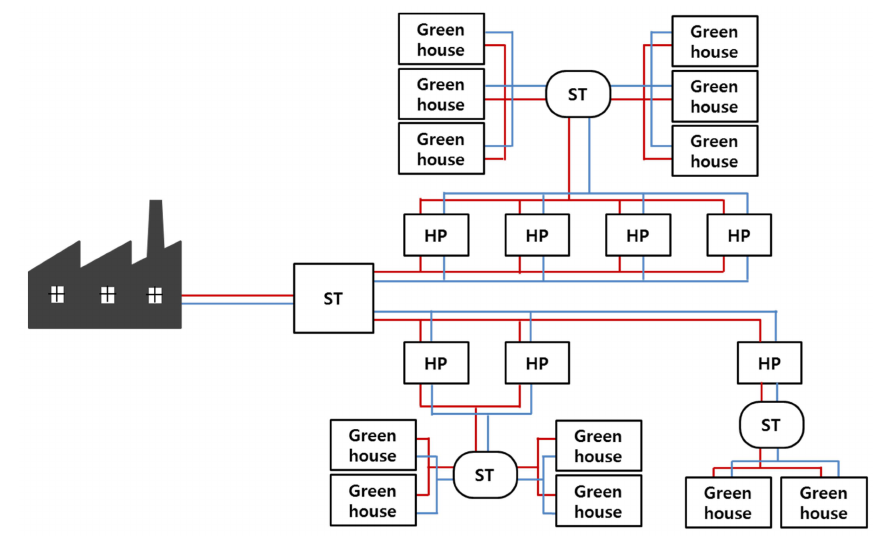
Figure 3. Possible design of pipeline.